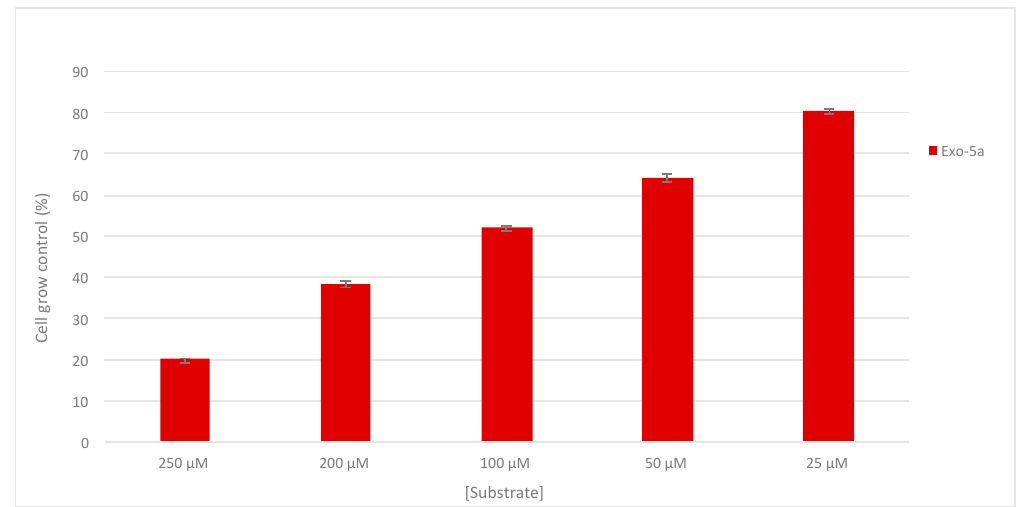
Figure 5. Antiproliferative effect of exo -5a against SH-SY5Y cells. The cell growth was measured by the SRB assay and reported as % relative to untreated control. Data are expressed as means ± SD of three independent observations ( p < 0.05).